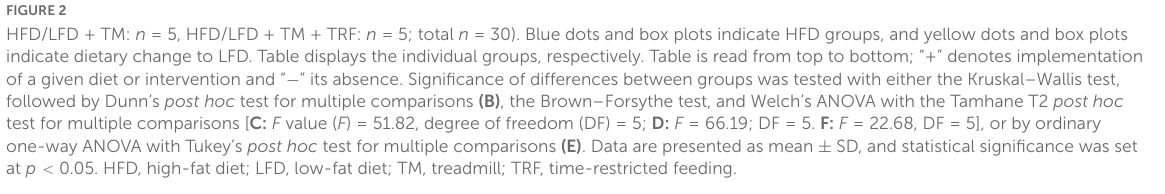
and a moderate correlation by light colors ( > 0.40 or < -0.40) (35). The analysis was carried out in R (version 4.0.2, R